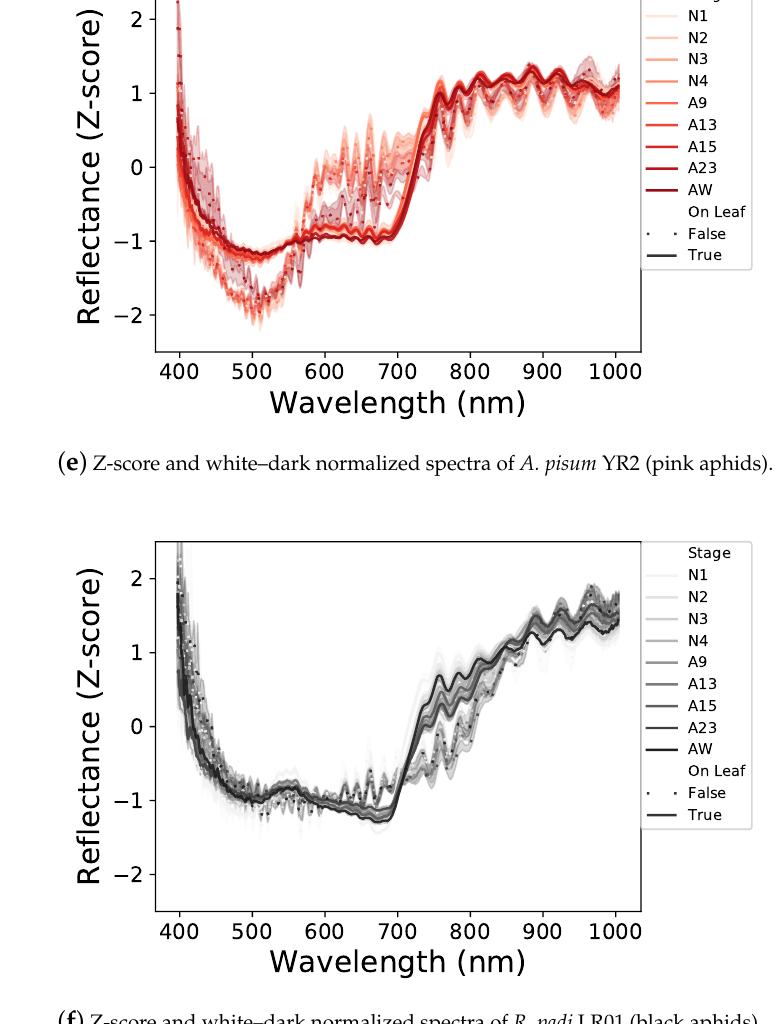
( f ) Z-score and white–dark normalized spectra of R. padi LR01 (black aphids). Figure 3. Normalized light reflectance spectra of the three aphid lines before ( a – c ) and after ( d – f ) Z-score standardization. All aphid stages, on a white background or a leaf, are represented. Spec- tral signatures differ between aphid lines and neutral and leaf backgrounds. Differences in light reflectance between nymphal and adult stages are reduced by the Z-score application.